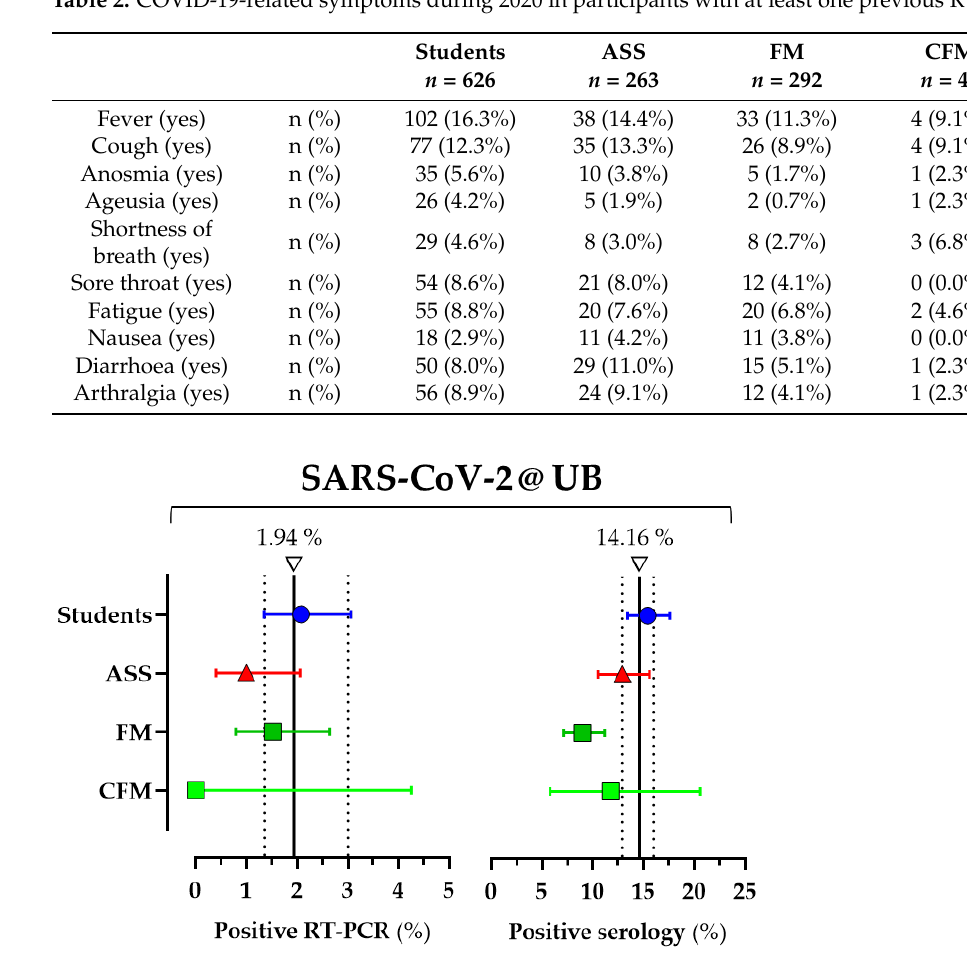
Figure 2. SARS-CoV-2 infection prevalence (assayed by RT-PCR and IgG serology) estimated using sampling weights by UB community groups. Results are expressed as percentages of subjects showing positive RT-PCR for SARS-CoV-2 (prevalence of current infection) or antibodies against SARS-CoV-2 (seroprevalence or prevalence of past infection) with 95% Cis, according to UB community groups: students, administrative and service staff (ASS); faculty members (FM) and clinical faculty members (CFM). A vertical line represents the overall prevalence (RT-PCR or serology) and the dotted lines the 95%CI.